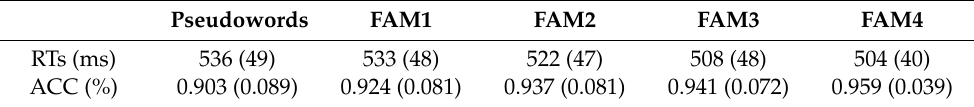
Table 2. The behavioral performances of words with the four familiarity levels and pseudowords. The bracket values indicate standard deviations. Abbreviations: FAM1 (most unfamiliar), FAM2 (slight unfamiliar), FAM3 (slight familiar), and FAM4 (most